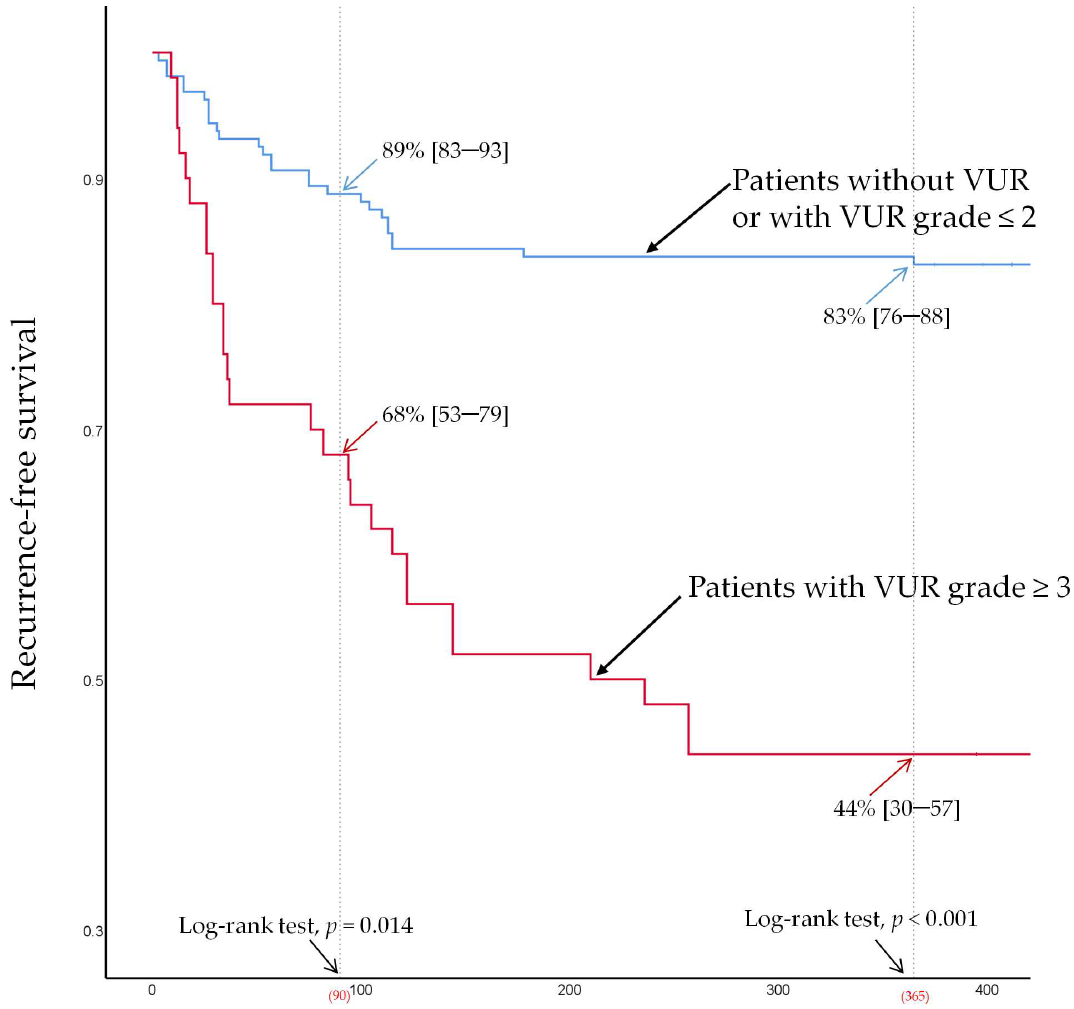
Figure 3. Recurrence-free survival for patients with or without a vesicoureteral reflux grade ≥ 3.